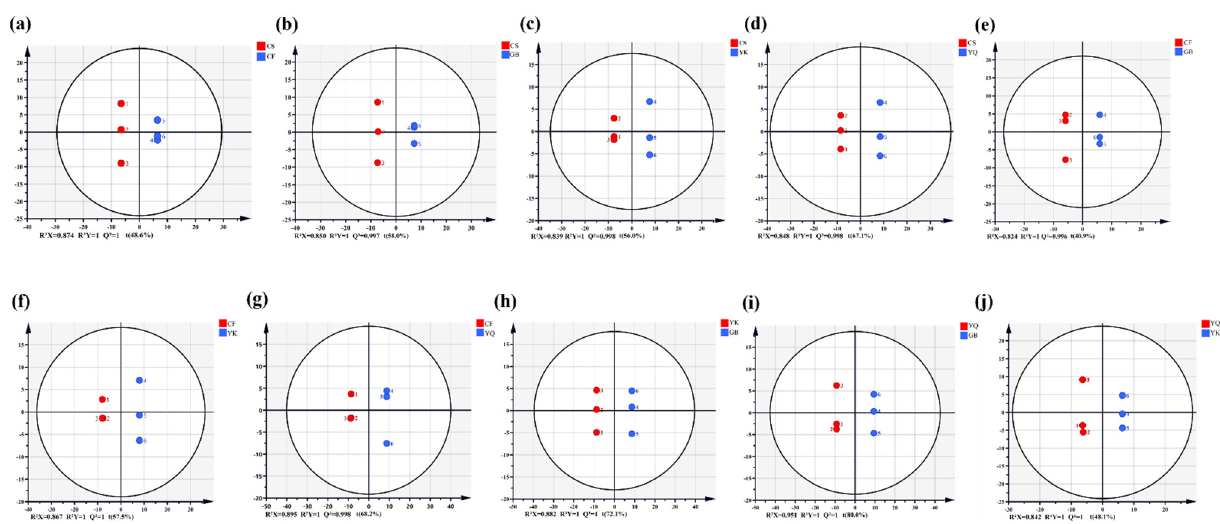
Figure 4. OPLS-DA score map of phenolic compounds of FDRs from different producing areas. ( a – j ) OPLS-DA model plots for the comparison group CS vs. CF, CS vs. GB, CS vs. YK, CS vs. YQ, CF vs. GB, CF vs. YK, CF vs. YQ, GB vs. YK, GB vs. YQ and YK vs. YQ, respectively.